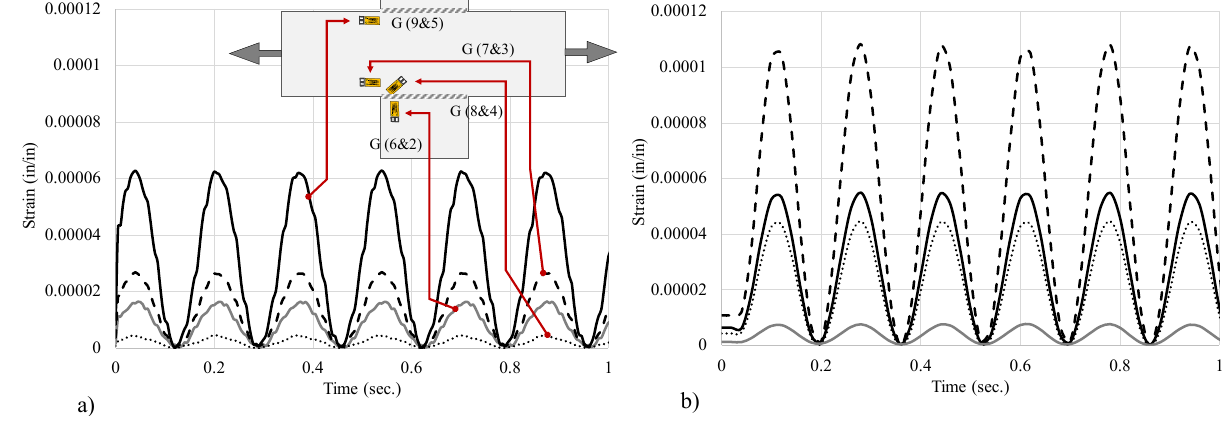
Figure 30. Recorded strains: ( a ) pre-notch; ( b ) post-notch.